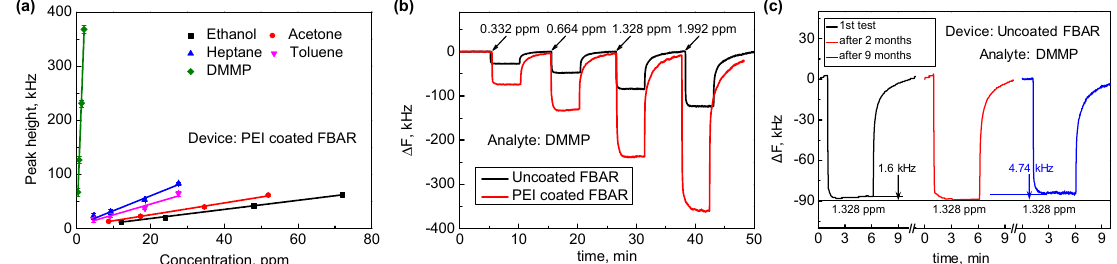
Figure 2. ( a ) The linear relationship between the response of PEI–coated FBAR sensor and the concentration of various vapors. ( b ) Reversible response of uncoated FBAR and PEI–coated FBAR sensor to DMMP with concentrations at 0.332, 0.664, 1.328 and 1.992 ppm. ( c ) Stability of uncoated FBAR sensor at ambient condition in 9 months.